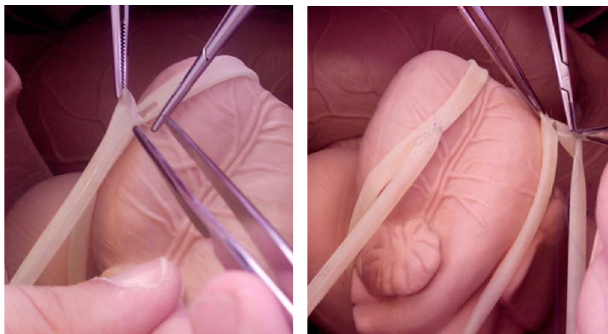
Fig. 6 - Resident training coronary anastomosis with silicone tubes positioned in the path of the coronary arteries into the chest cavity of the dummy.